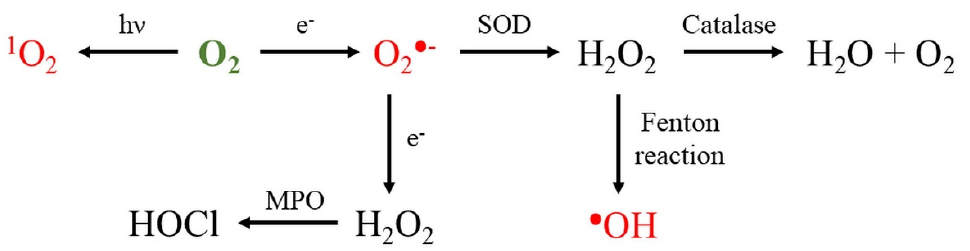
Figure 1. Formation of reactive oxygen species. Abbreviations: SOD = superoxide dismutase; MPO = myeloperoxidase; O 2 = oxygen; 1 O 2 = singlet oxygen; O 2 ●− = superoxide; H 2 O 2 = hydrogen peroxide; ● OH = hydroxyl radical; HOCl = hypochlorous acid; and h ν = radiation. ROS colored in red are free oxygen radicals.